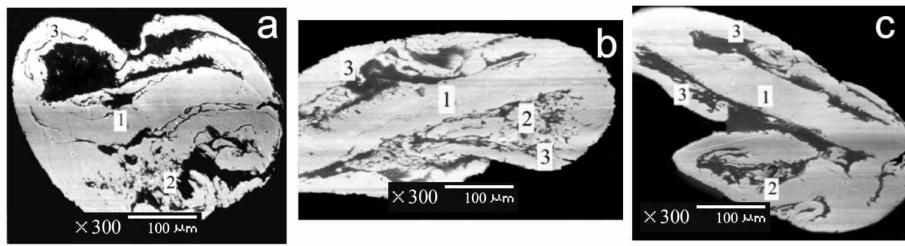
Figure 9. Cross-sections of various forms of hollow gold obtained during the experiment: ( a ) spherical hollow; ( b ) canoe-shaped; ( c ) curved; 1, internal partition; 2, filamentous twisted gold; 3, shell.